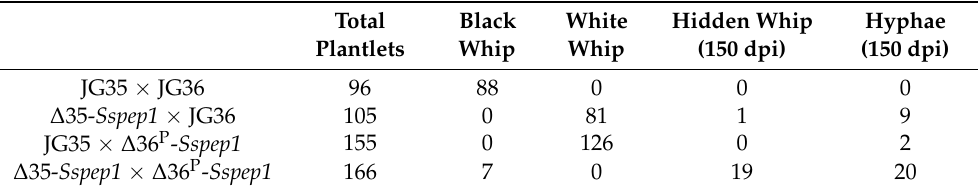
Figure 5. Sspep1 deletion altered whip morphology and teliospore development. Histopathological analysis was performed on the whips or whip-less plantlets. Sections were stained with 0.4% trypan blue and viewed under a microscope. Note that no teliospores were present in white whips inoculated with ∆ 35 -Sspep1 × JG36 or JG35 × ∆ 36 P -Sspep1 . Tiny and hidden whips were found in plantlets inoculated with ∆ 35 -Sspep1 × ∆ 36 P -Sspep1 ; the red boxes represent the enlarged portions of the sections. Scale bar: 200 µ m. Table 1. Characterization of plantlets inoculated with wild-type or mutant strains of S. scitamineum